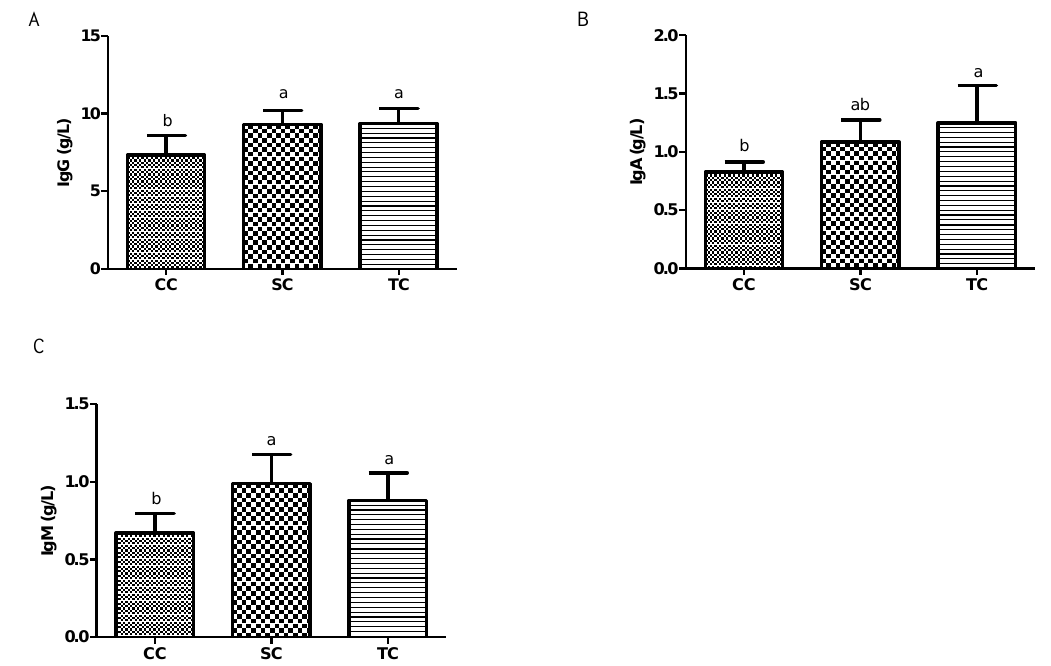
Figure 1. E ff ects of fermented soybean meal (FSBM) on serum immunoglobulin concentrations in broilers. ( A ) IgM; ( B ) IgG; ( C ) IgA. CC, control group; SC, 25% of soybean meal (SBM) replaced with fermented soybean meal (FSBM); TC, 50% of soybean meal (SBM) replaced with fermented SBM (FSBM). a,b Means with di ff erent letters within columns indicates significant di ff erences at p <